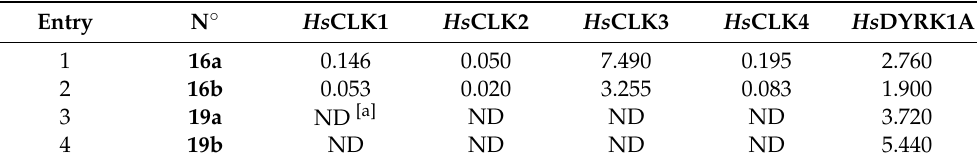
Table 3. IC 50 data ( µ M) for the inhibition of human kinases CLK1-4 and DYRK1A by the quinazolines 16 and 19 . Each concentration of compound was tested in